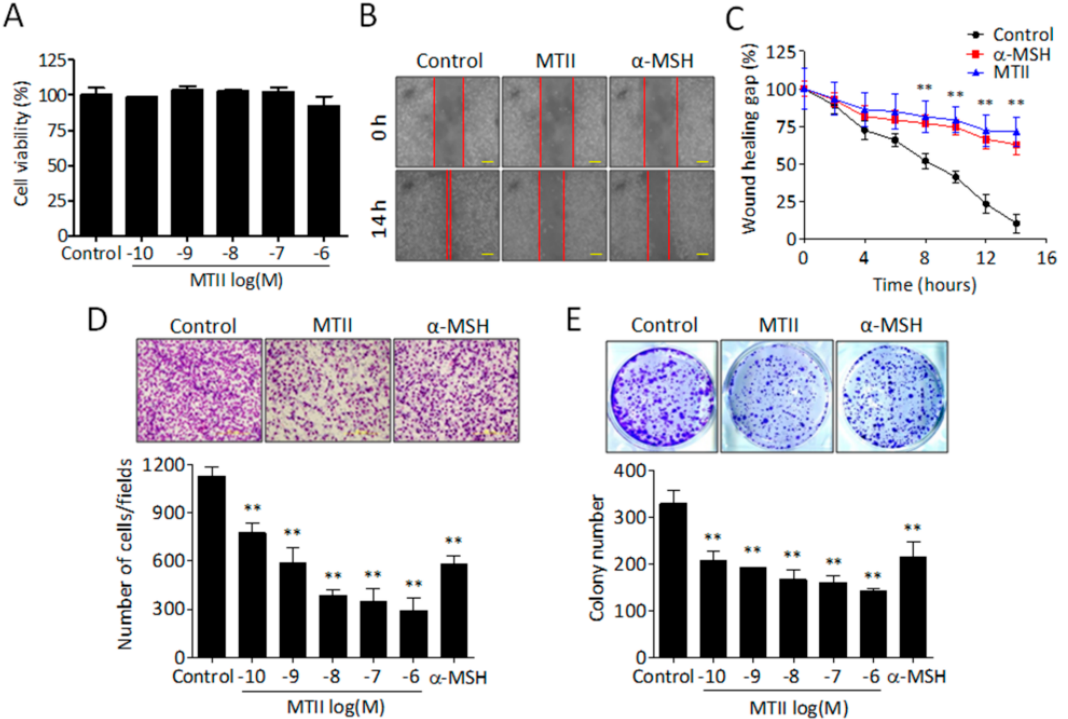
Figure 1. Effect of MTII on tumorigenicity of melanoma cells. ( A ) Cell viability was determined by MTT assay. Data were presented as the mean ± SD from triplicate experiments. ( B , C ) After cells were treated with MTII and α -MSH peptides at the concentration 10 nM, the cell migration capability was determined by scratch wound healing assay. The average of the gap width was measured from different duplication experiments and expressed as the mean ± SD. ( D ) After cells were treated with MTII (0.1 nM–1 μ M) and α -MSH peptides (10 nM), respectively, the cell invasive ability was determined by Boyden chamber using a Matrigel-coated membrane. The number of invaded cells was calculated from three different fields for each experimental group and expressed as the mean ± SD. ( E ) Cells treated with the indicated concentration of MTII and α -MSH peptides (10 nM), respectively, for 7 days. Cell colonies were visualized by crystal violet staining. **: p < 0.01.